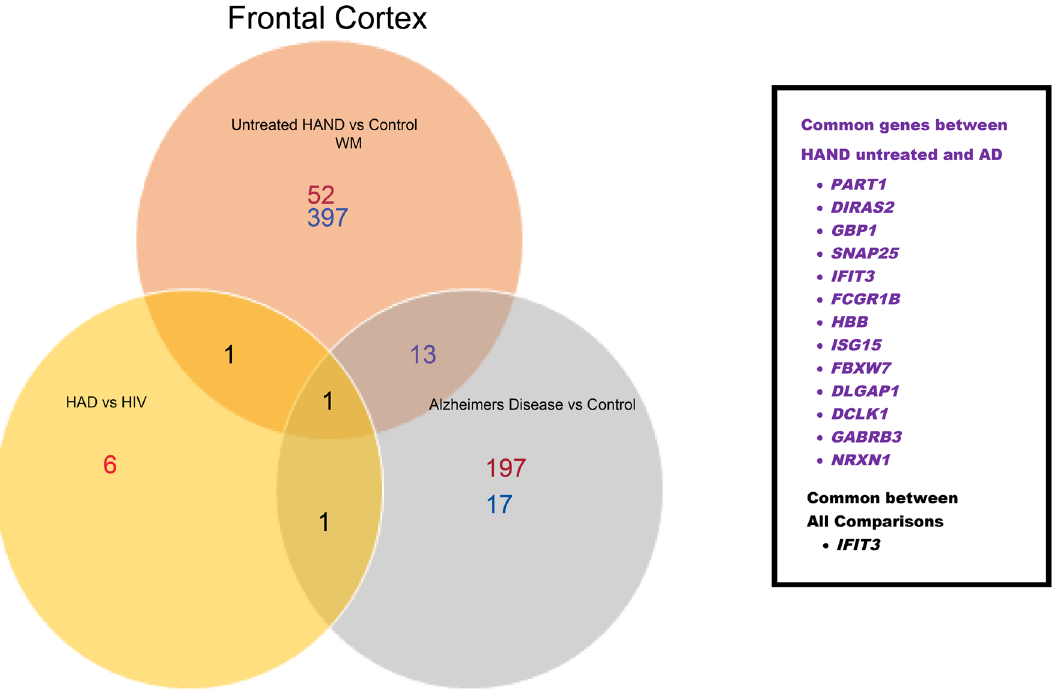
Figure 9. SAM results in comparison of untreated HAND and AD patients (frontal cortex). This Venn diagram represents the SAM results that were considered significant (q-value = < .05). Both SAM analyses were done independently and then compared. The frontal cortex regions of AD patients had 17 upregulated genes (blue) and a total of 197 downregulated genes (red). The frontal cortex of HAD patients showed a total of 6 downregulated genes (red). The white matter of untreated HAND patients had a total of 397 upregulated genes (blue) and 52 downregulated genes (red). Untreated HAND patients and AD patients shared 13 common genes. However, the only common differentially expressed gene based on mRNA expression was IFIT3